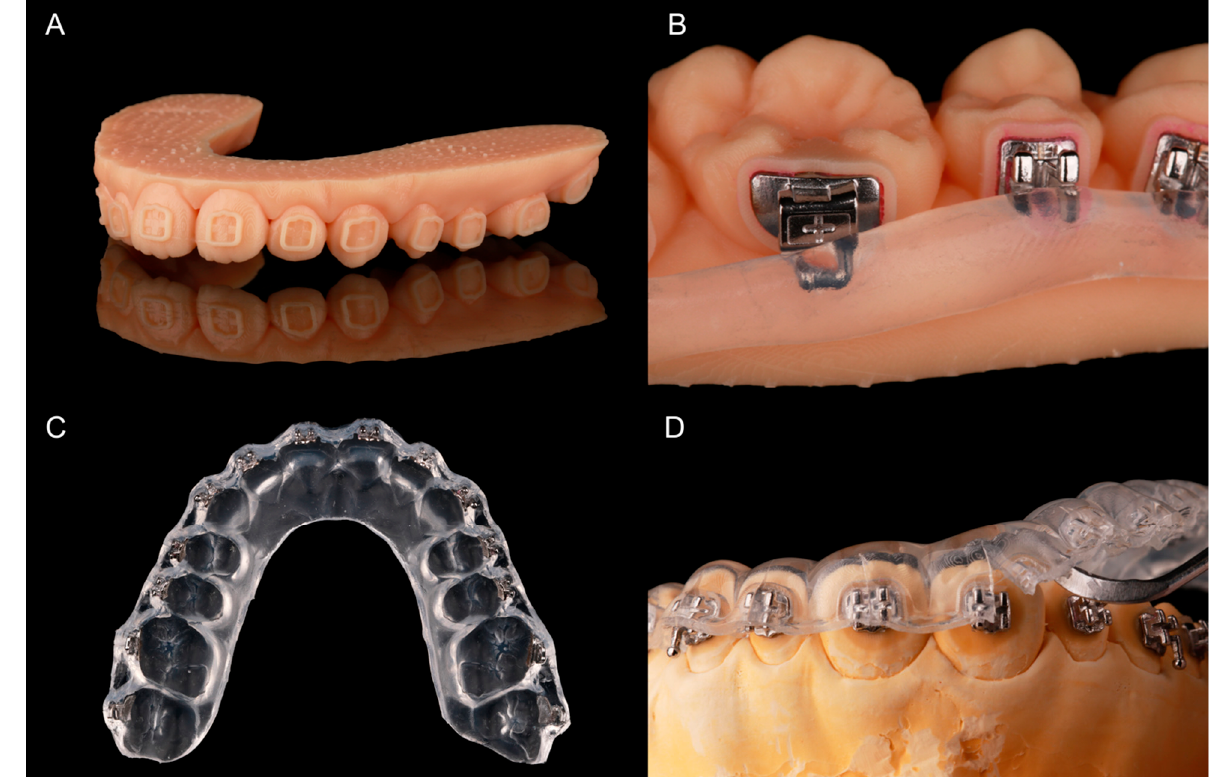
Figure 4. Fabricating the pressure ‐ molded transfer trays: ( A ) printed model with frames for brackets and tubes; ( B ) provisory bonded brackets and tubes with silicone for blocking ‐ out; ( C ) pressure ‐ molded transfer tray with embedded brackets and tubes; ( D ) tray removal with a scaler after bonding.